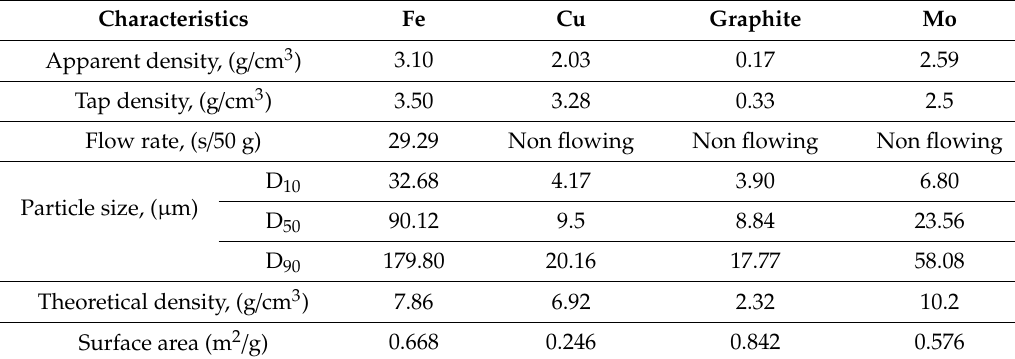
Table 1. As-Received Powder